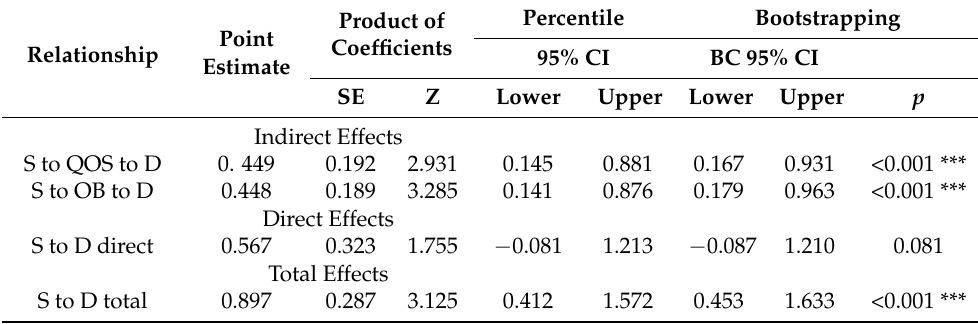
Table 1. Parallel multiple mediator model for stress on depressive